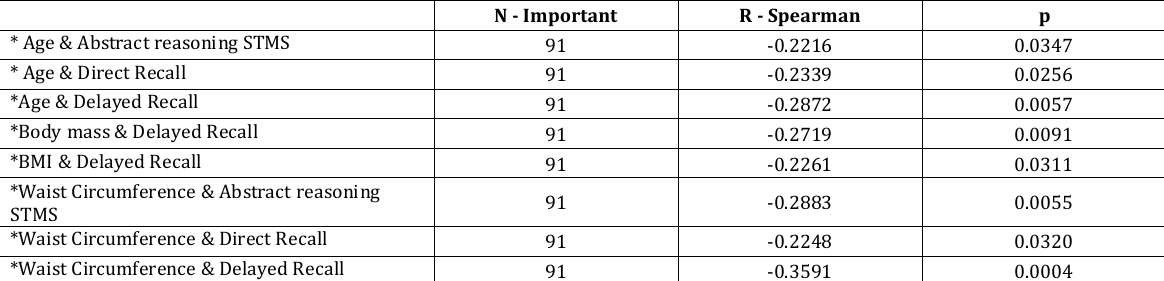
Table 2. Correlation of Spearman’s ranks between the BMI index, body mass, waist circumference and cognitive functions for all responders* - marked coordinates of correlation are significant at p <0.05. N - Important R - Spearman